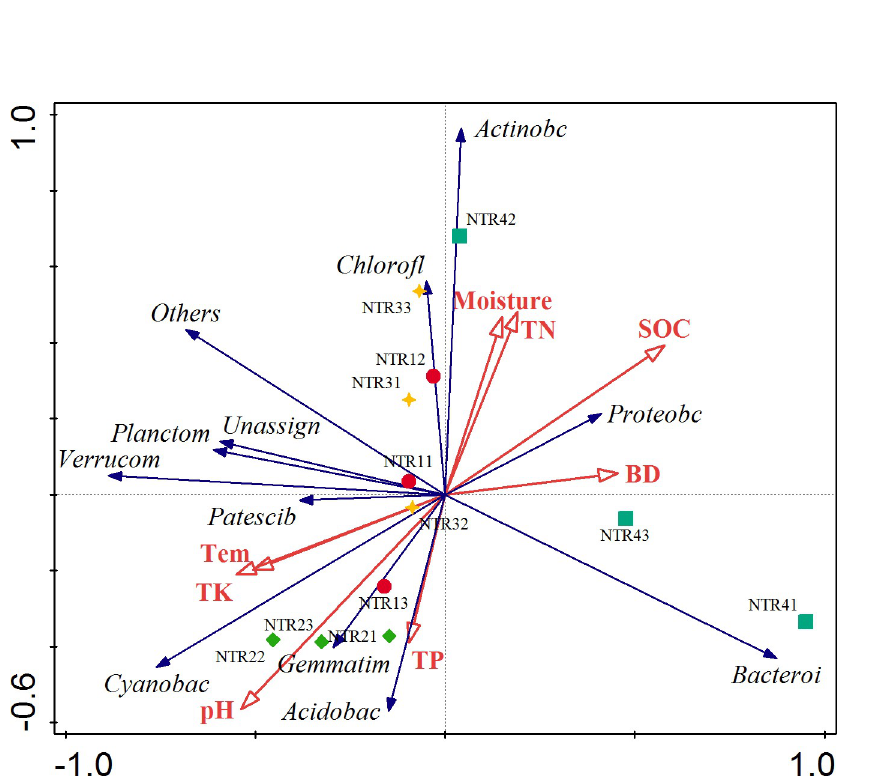
Fig 5. Summary of redundancy analysis, showing the relationships between soil parameters and soil bacterial community structure. Red lines represent soil parameters, blue lines represent the bacterial phylum-level taxonomy, and graphics of different colors represent soil samples from all replicates (n = 3) of each crop residue mulching treatment. Numbers after treatment abbreviations denote the experimental replication. BD, soil bulk density; SOC, soil organic carbon; TN, total nitrogen; TP, total phosphorus; TK, total potassium; NTR1, no tillage and all crop residue removed; NTR2, no tillage and 30% crop residue mulching; NTR3, no tillage and 60% crop residue mulching; NTR4, no tillage and all crop residue